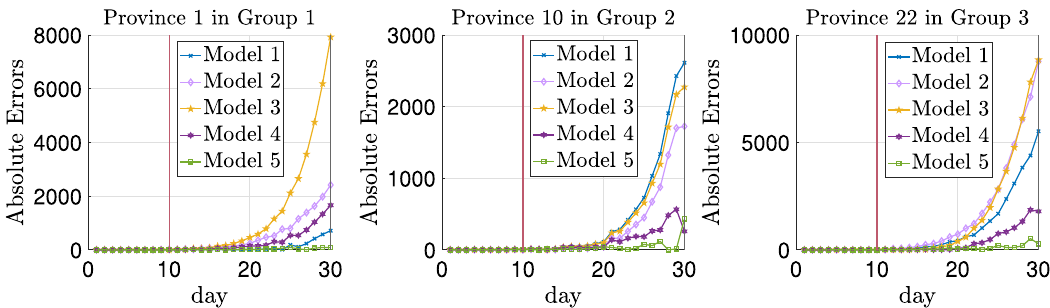
Figure 6. Absolute errors of the fitted trajectories for simulated data in the three provinces chosen from the total thirty ones. The vertical lines show the threshold of training-testing